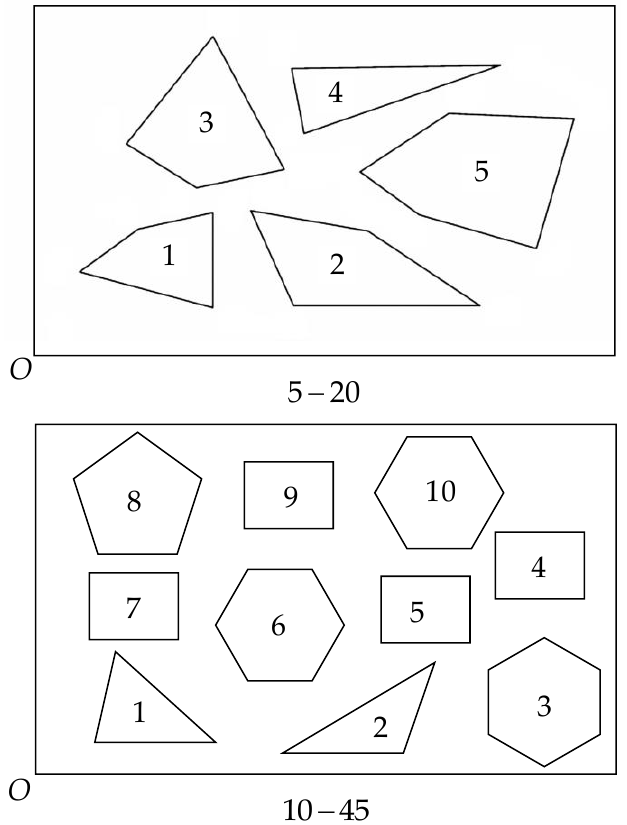
Figure 8. Layout diagram of 2 test cases.